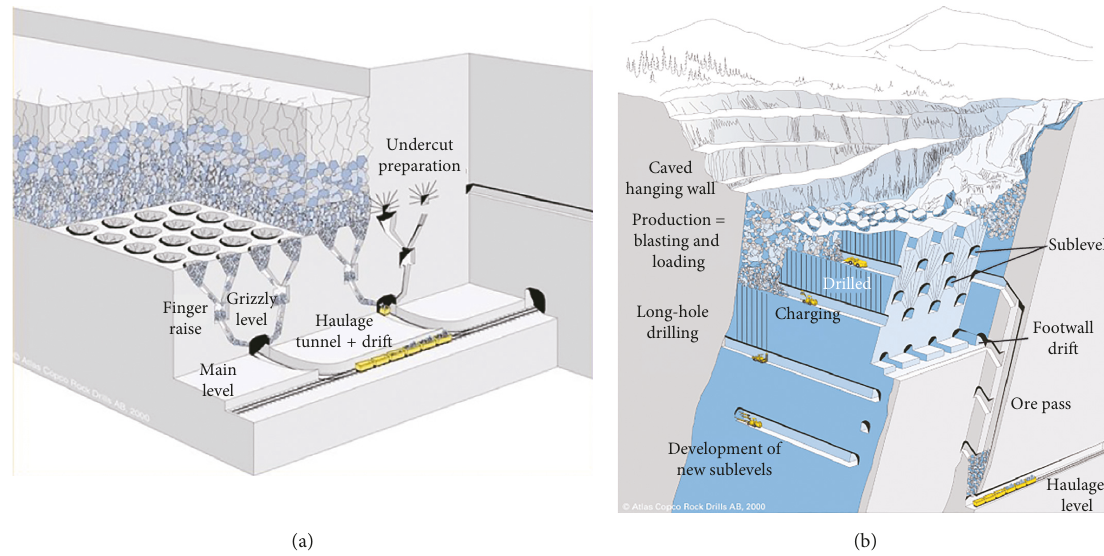
Figure 2: Illustration of typical (a) block caving mining and (b) sublevel caving mining operations (image copyright: Atlas Copco).